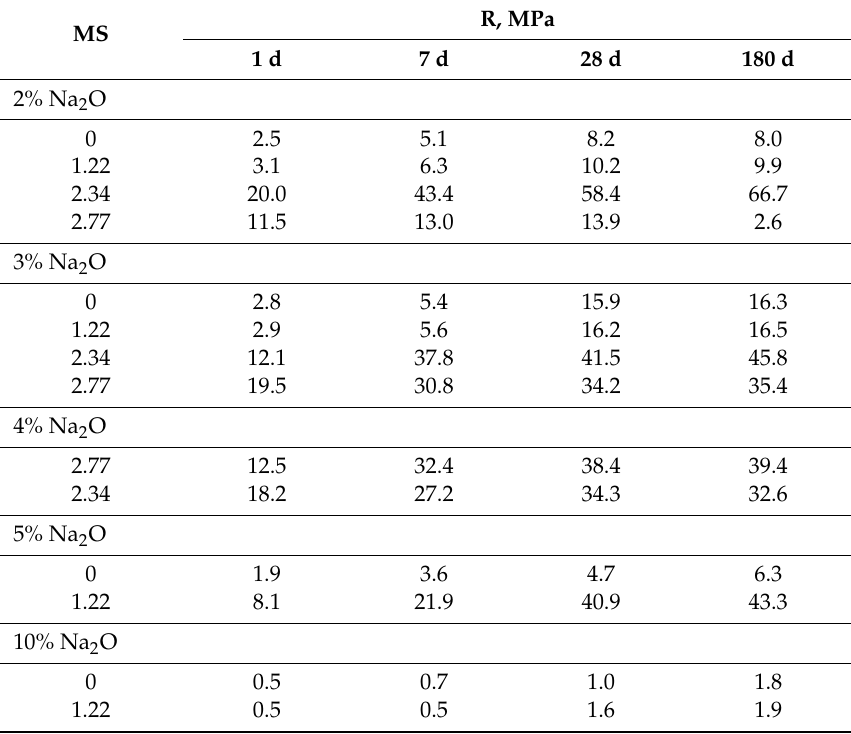
Table 6. The compressive strength (R) of the NT–alkaline agent binder prepared using heat treatment. MA of the NT was carried out in air for 270 s. The percentage of Na 2 O corresponded to the sodium oxide in alkaline agent (liquid glass or NaOH solution) relative to weight of the NT. Curing conditions are described in the text (MS: silica modulus).